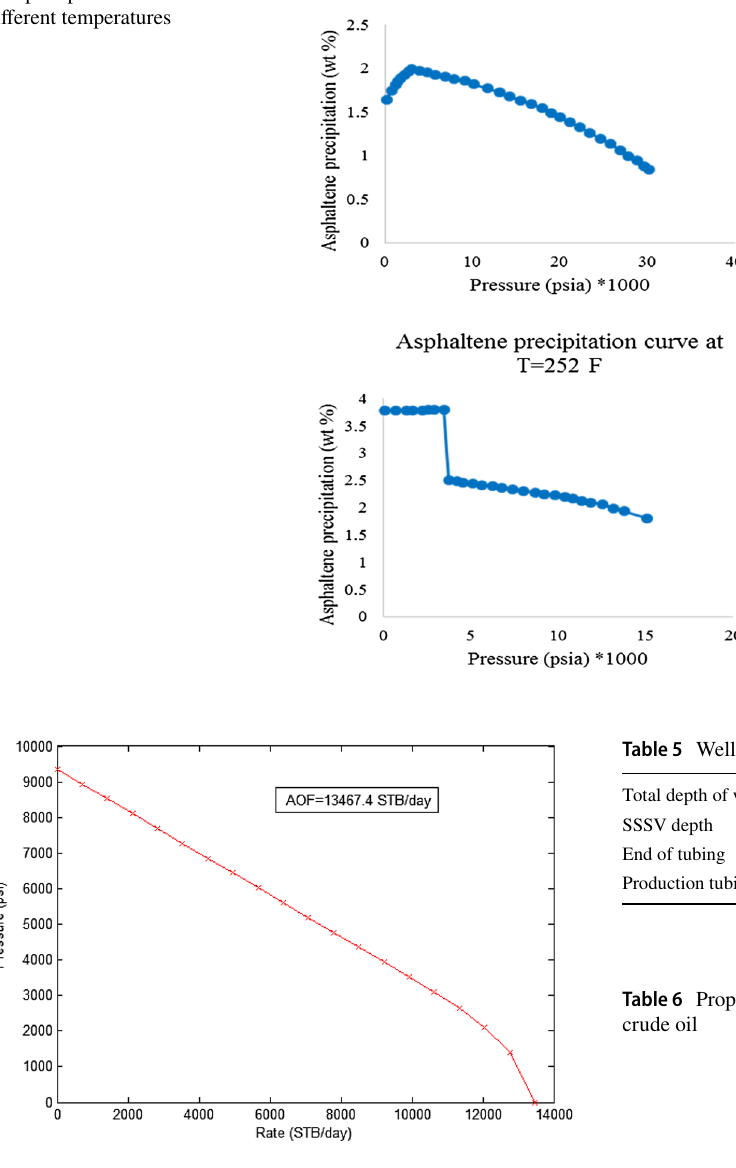
Fig. 3 Comparison of asphal- tene precipitation curves at different temperatures